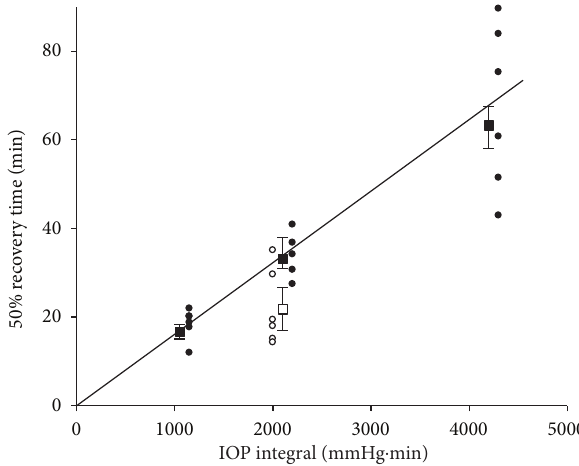
F 7: Relationship between the 50 recovery time (mins) for nSTRamplitudeasafunctionofIOPtimeintegralforelevationto70 (�lledsymbol)and50mmHg(un�lledsymbols).Individualanimals % are shown, and squares indicate bootstrapped mean for group data; error bars, 2.5 and 97.5 bootstrap con�dence limit. Reprinted from [57] with permission. e Association for Research in Vision and Ophthalmology remains the copyright % %